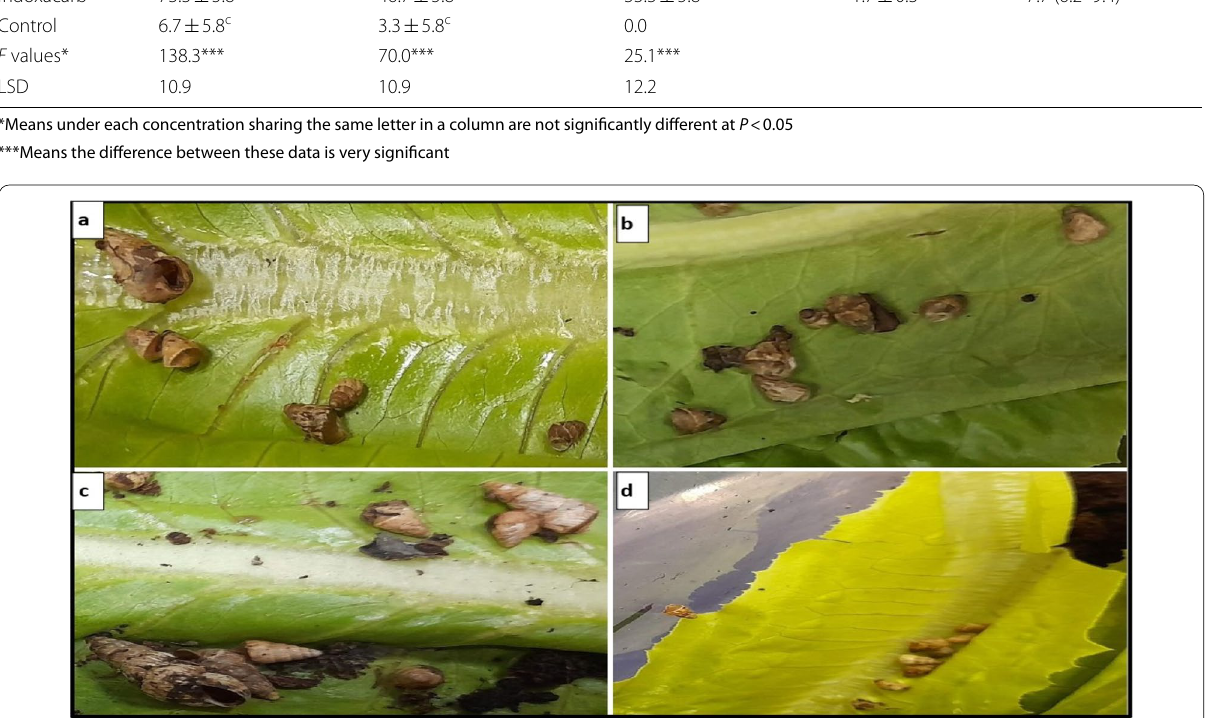
Fig. 5 Effect of nanoformulations of chlorfenapyr ( a ), imidacloprid ( b ), indoxacarb ( c ) compared with untreated (control) ( d ) on the conical snails